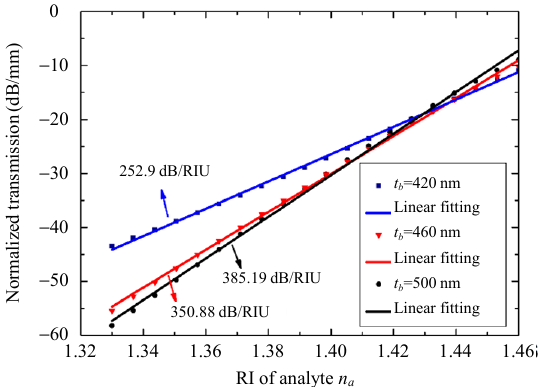
Fig. 7 Dependence of the normalized transmission on RI of the analyte for different thicknesses of the buffer layer.